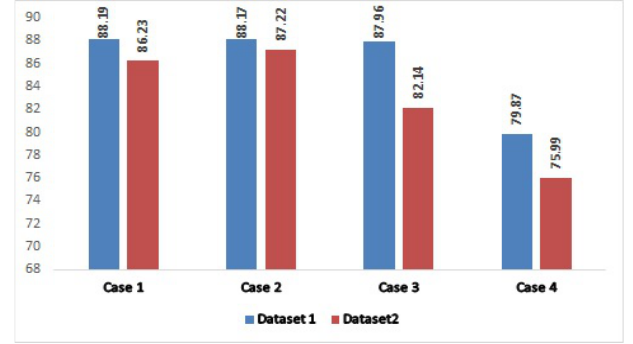
Figure 1. Accuracy measure of both the dataset for all the cases in percentage.